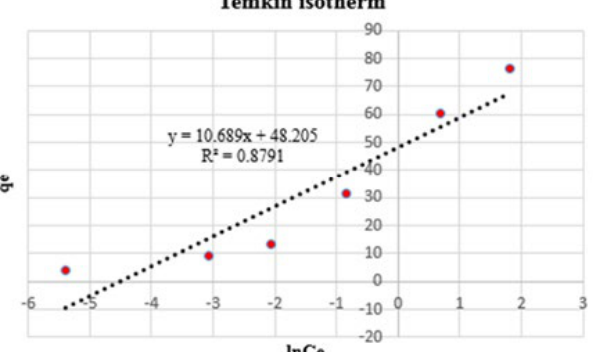
Fig 12. Temkin isotherm model for adsorption of cadmium by palladium oxide nanoparticles